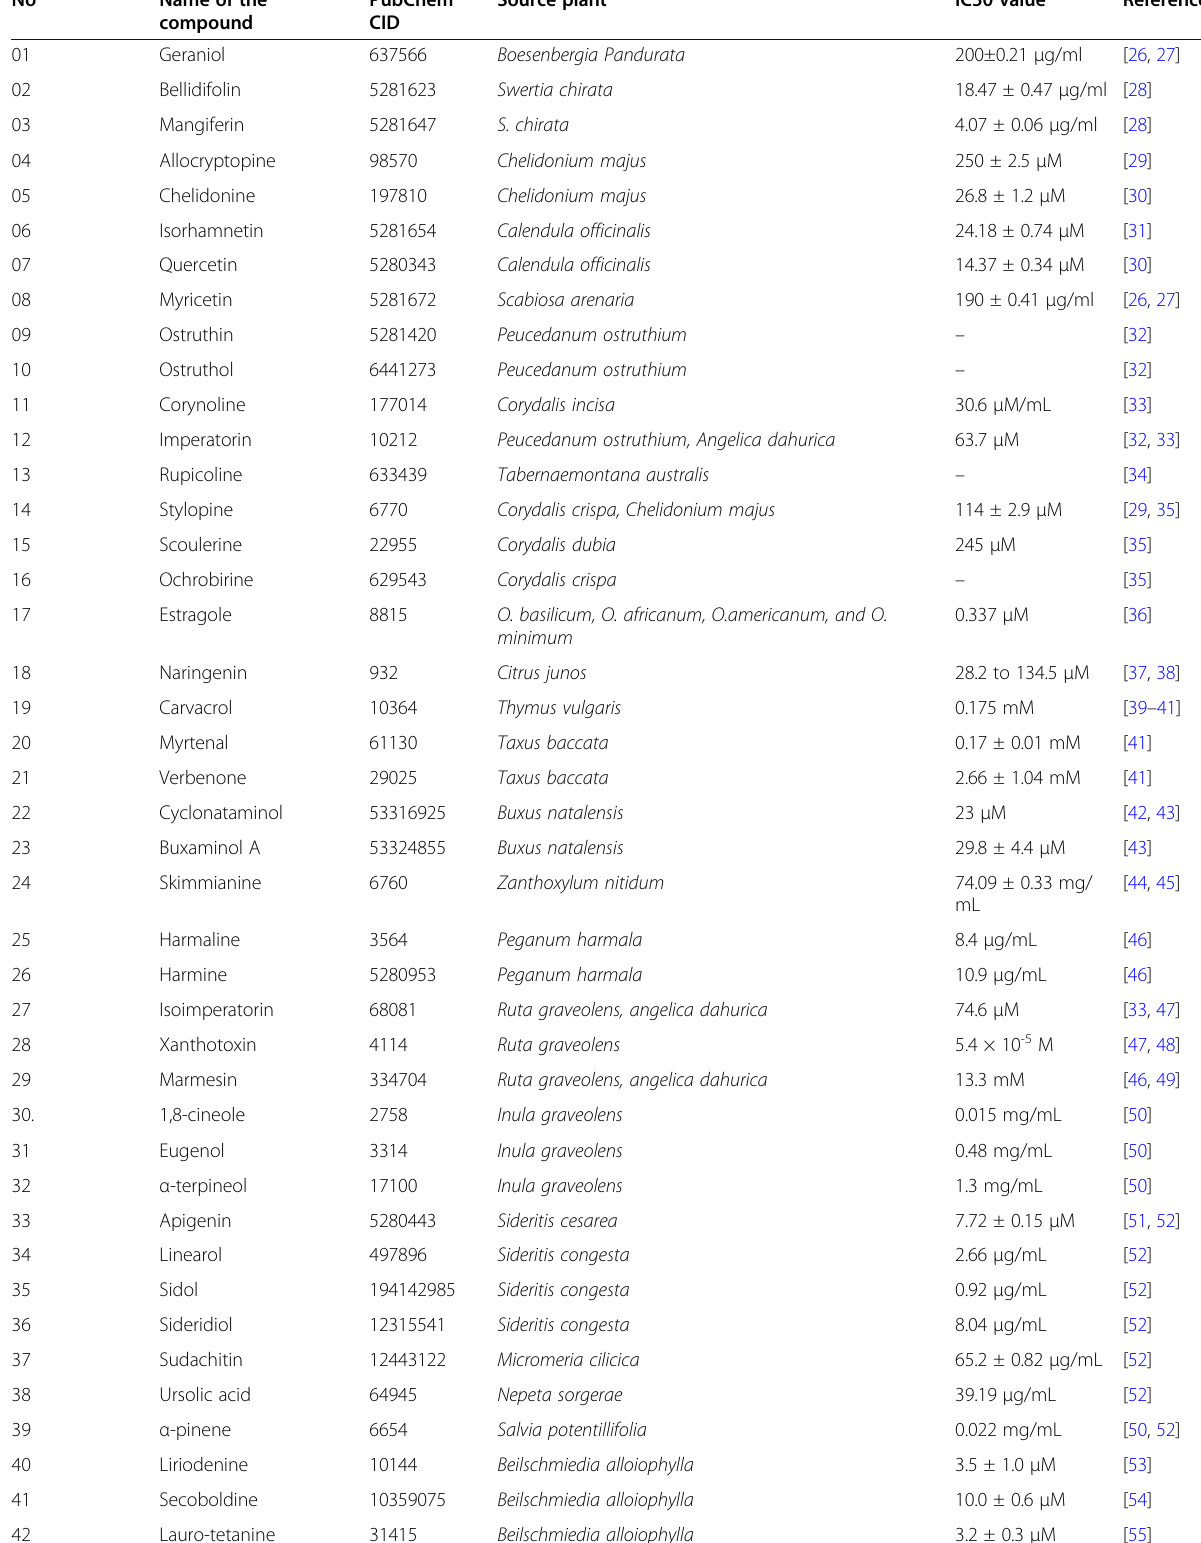
Table 2 List of the 50 anti-AChE ligands with their experimental IC50 values used in the experiment